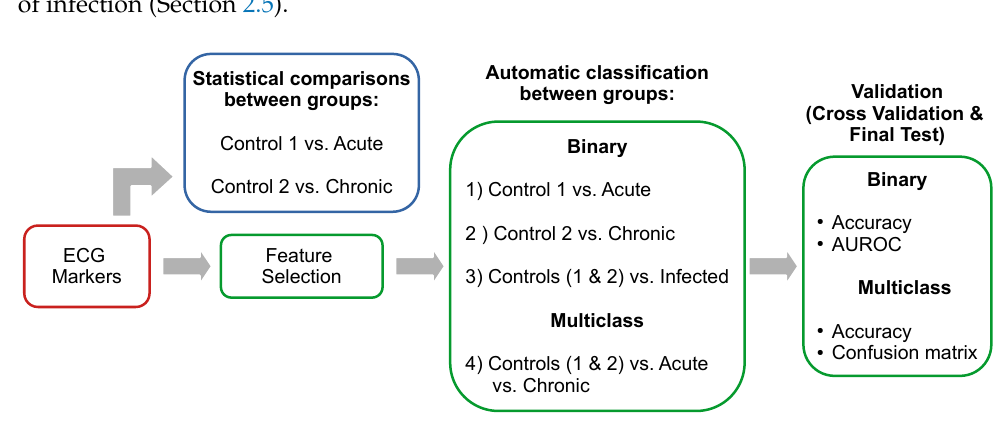
Figure 2. Proposed methodology for the analysis of ECG descriptors. In blue is the stage concerning statistical comparisons. The green section corresponds to the proposed methodology for feature selection, binary and multiclass classification, and the validation